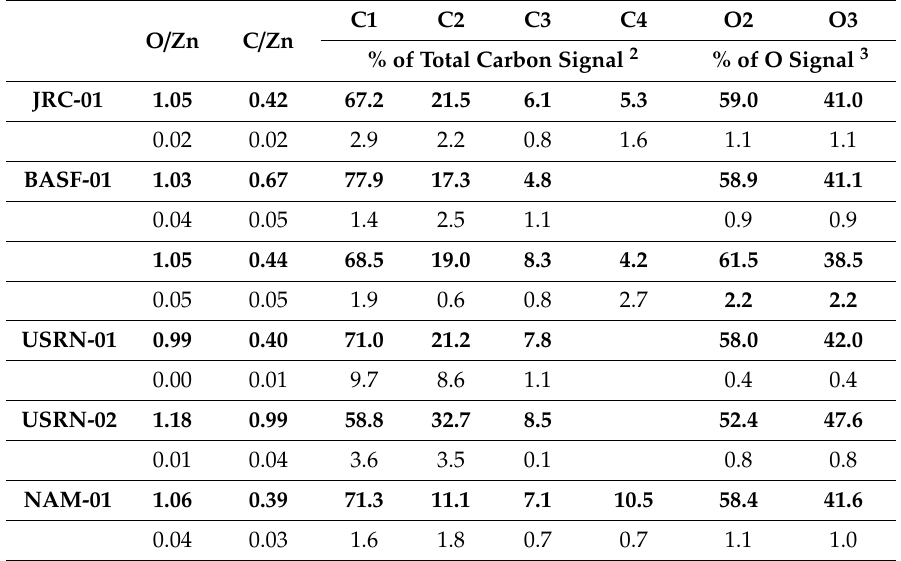
Table 3. Relative atomic compositions obtained from quantitative analysis of XPS data 1 for unmodified ZnO